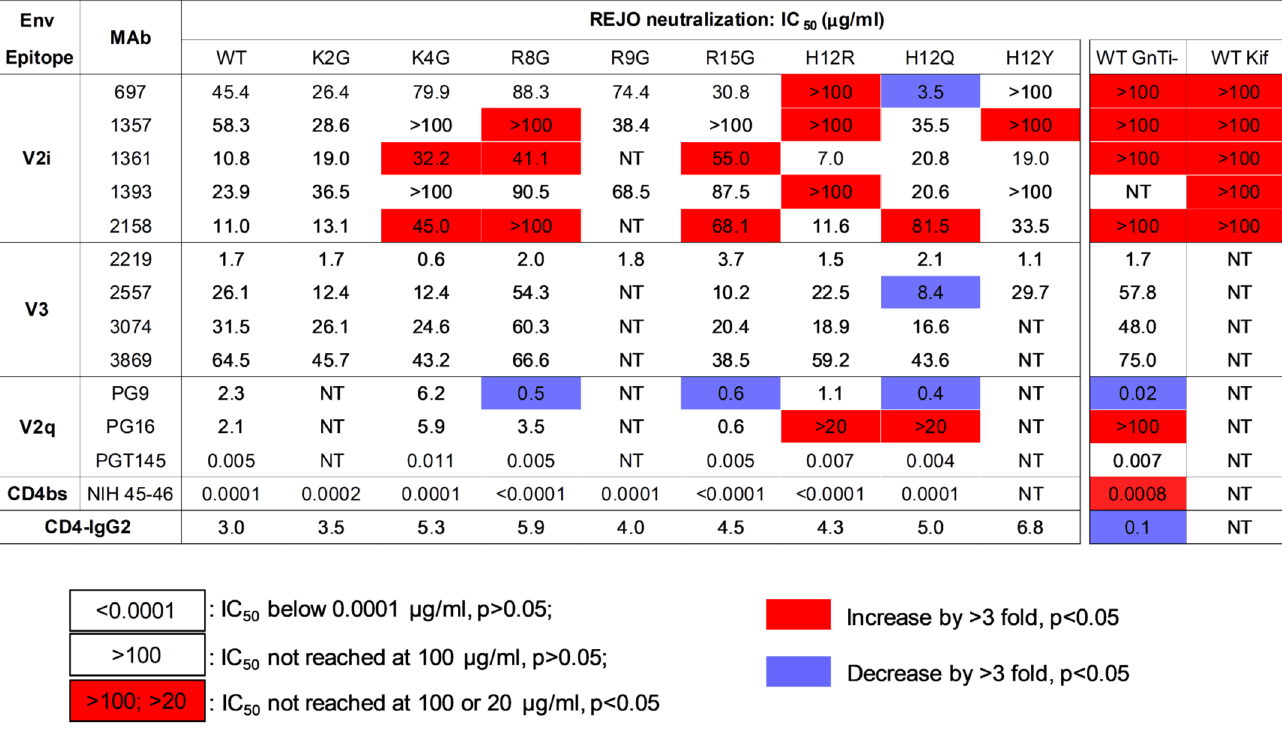
Fig 4. IC 50 values of REJO SP mutants vs. WT by MAbs targeting V2i, V3, V2q, and the CD4bs and by CD-IgG2. Neutralization assays were described in Fig 2. IC 50 ( μ g/ml) values that increase or decrease by > 3 fold and p < 0.05 as compared to that of WT by the same MAbs or CD4-IgG2 are shown in red and blue. Data from REJO WT viruses produced in 293S GnTI- cells or in 293T cells in the presence of kifunensine are also presented.